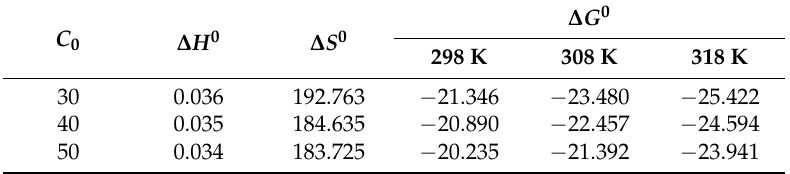
Figure 14. Linear fitting of thermodynamics. Table 5. Thermodynamic parameters.